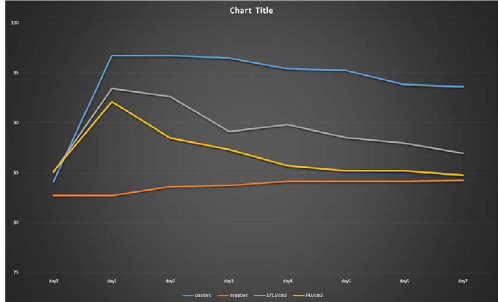
Fig. 3. Head circumference changes during the days of the experiment